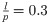
Required EOA reductions in BDBWUI.Our model suggests that increasing the supply duration to 23.75 hrs/day and the pressure to 17m will require utilities to reduce their EOA by a fraction (y-axis) that depends on how much of their current NRW is physical loss (p) and their allowed leakage increases (l). Box plots summarize these required EOA reductions under scenarios i) and ii) (i.e., a) lp=0.3 and b) lp=0.02).